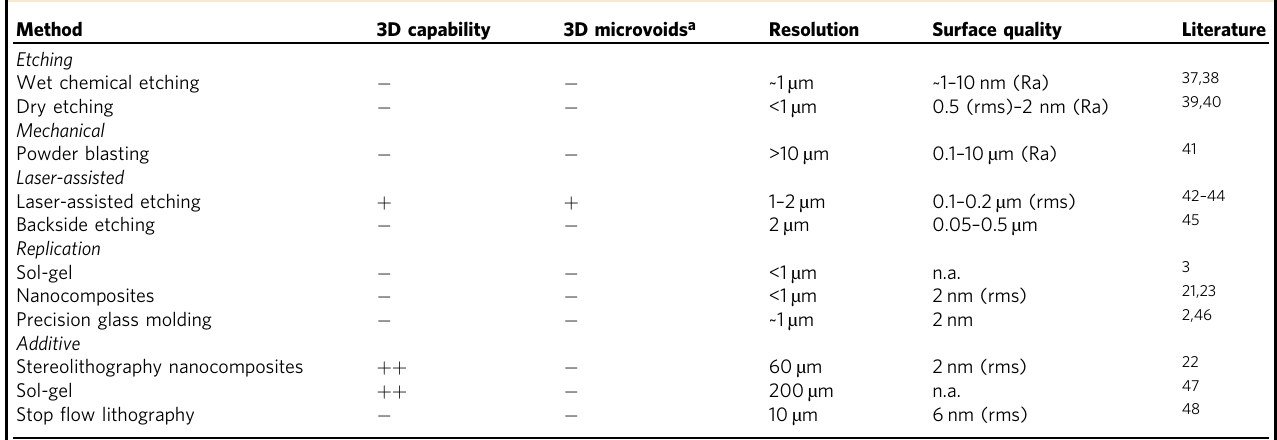
Table 1 Comparison of relevant methods for structuring fused silica glass